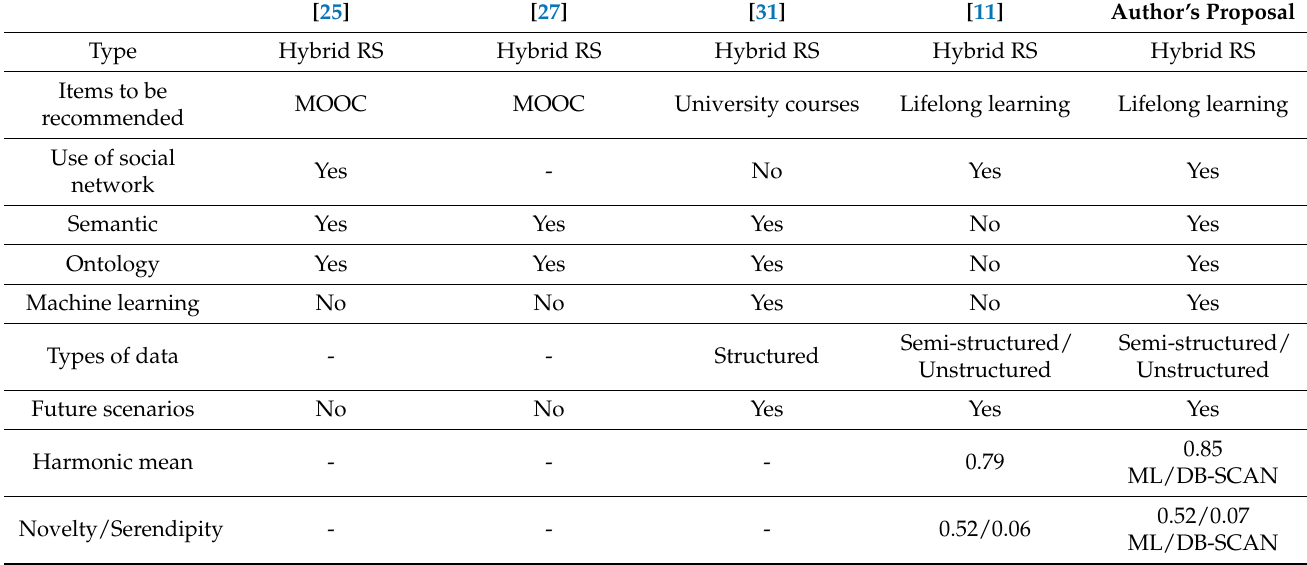
Table 7. Comparison of research